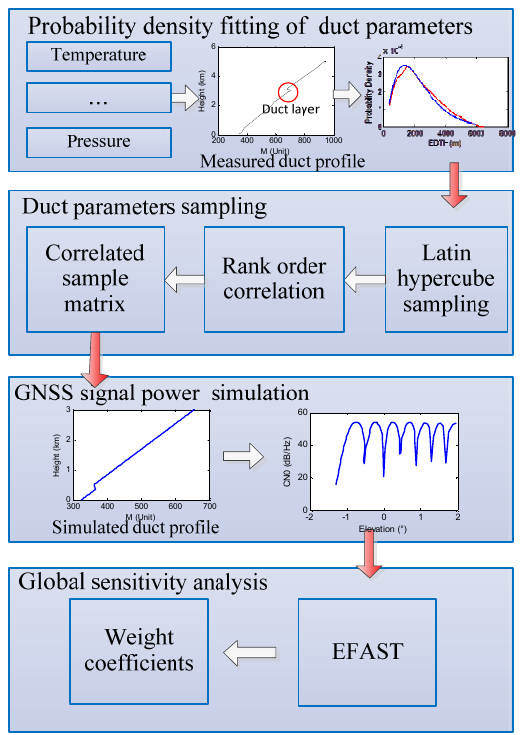
Figure 2. Flow chart of weight coefficient determination .